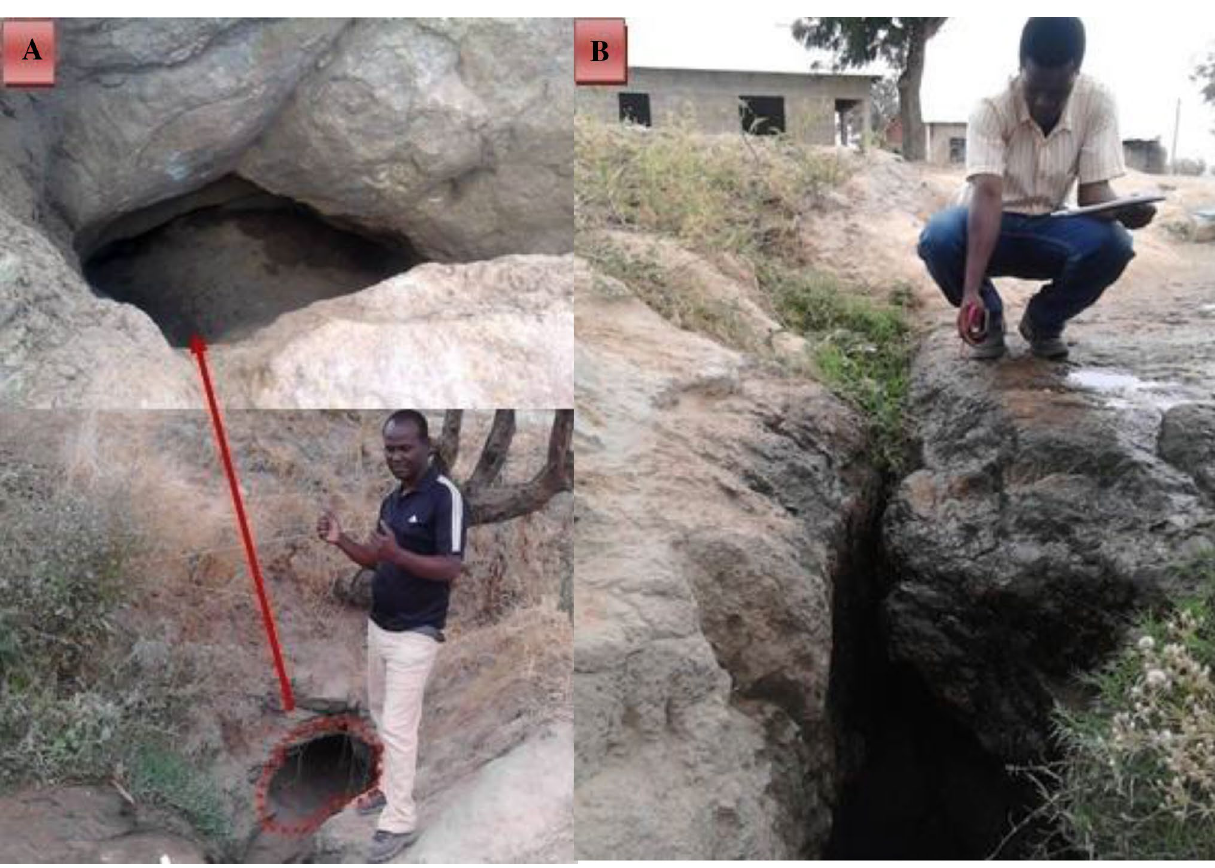
Fig. 4 Showing SDWs placed along natural fault systems. a Dowsing rods crossing on top of a SDW dug along a fault in Mahoma